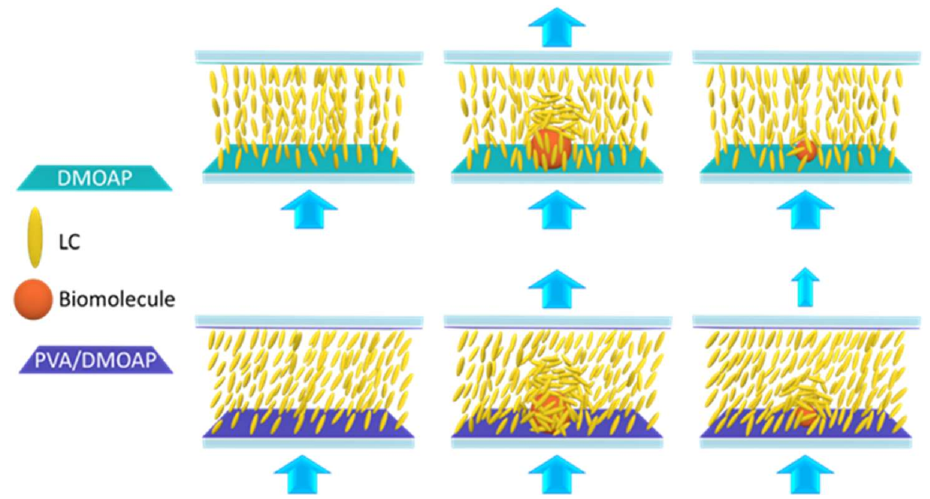
Figure 1. Signal amplification in LC-based biosensing through marginally tilted alignment of LCs achieved by the aligning layers of the PVA/DMOAP composite. Compared with the DMOAP- coated surface, LC molecules are in a tilted state on the PVA/DMOAP composite, which enables a greater extent of disturbance to occur in the presence of macromolecules such as BSA or small molecules such as cortisol, leading to enhanced optical signal. Blue arrows stand for the direction of light